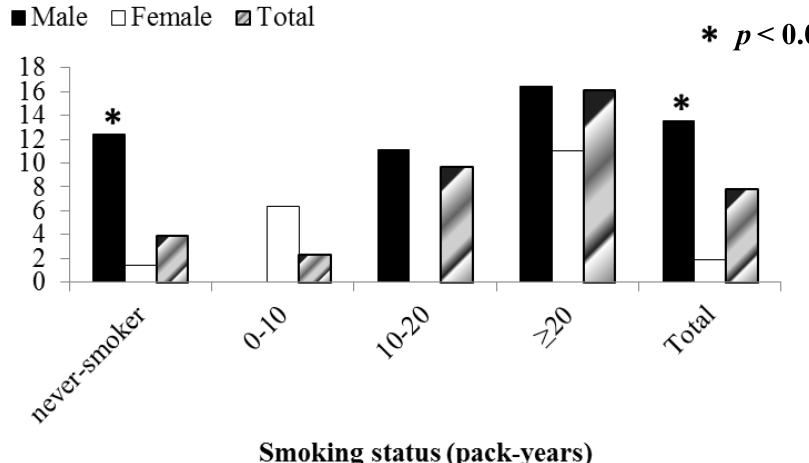
Figure 3. Prevalence of GOLD Stage I and higher by pack years and sex.